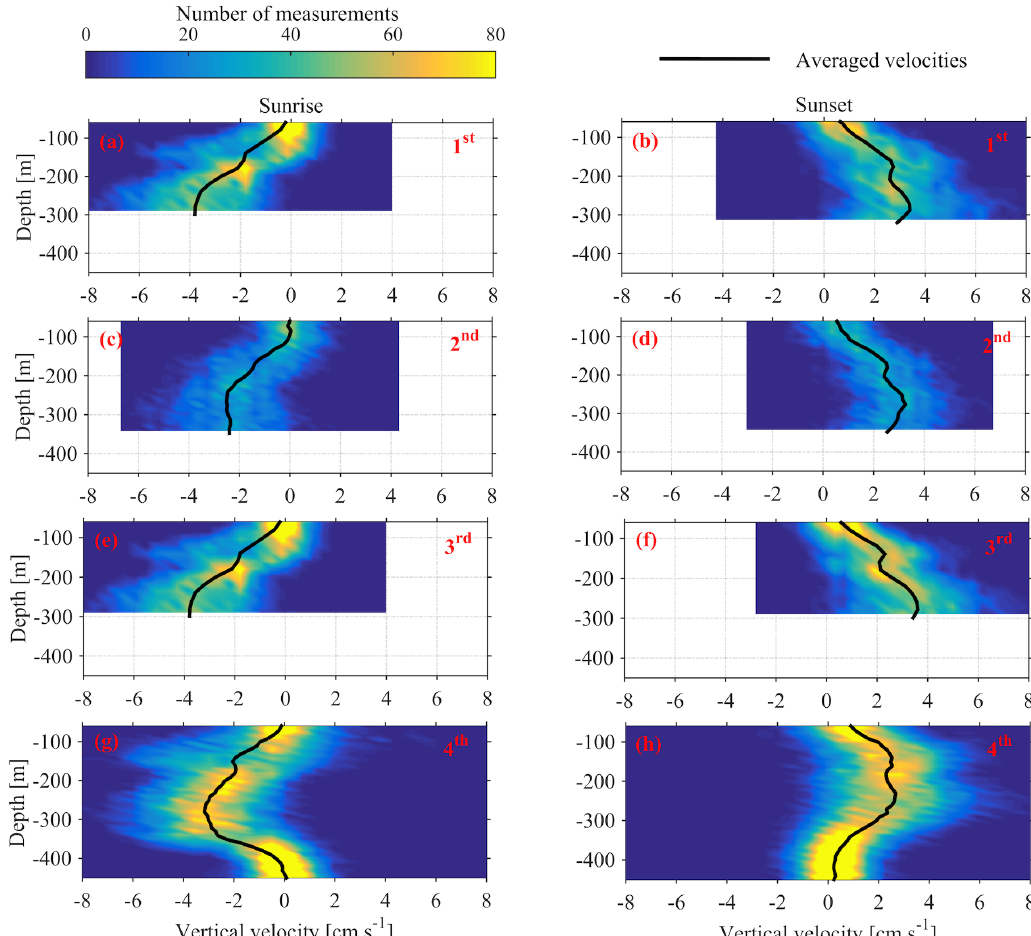
Figure 10. Depth distributions of the vertical velocities, measured 1h before and 1h after sunset and sunrise. The time average velocity at each depth is superimposed. Each row of panels refers to one deployment (first, second, third and fourth). The first column of panels corresponds to sunrise and the second column to